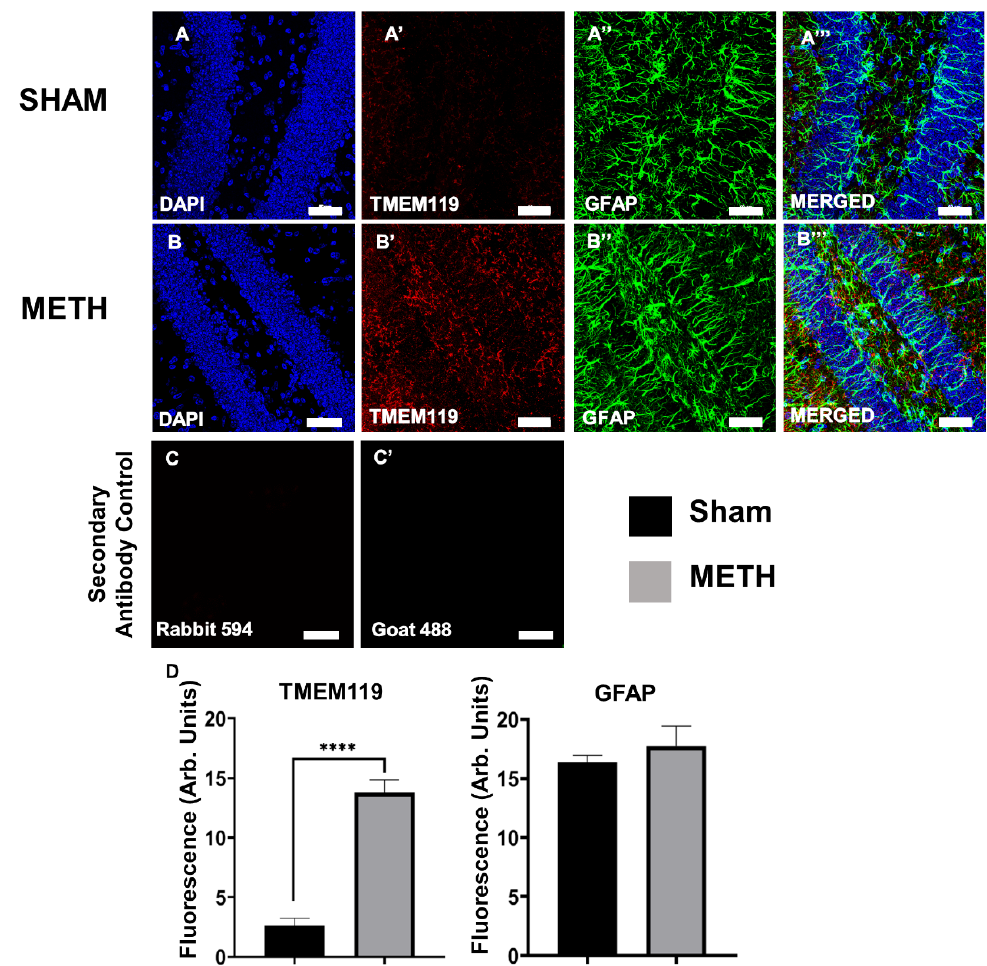
Figure 5. Acute METH exposure induces gliosis within the brain. Brain hippocampus cross-sections of sham-treated ( A , A’ , A’’ , A’’’ ) and METH-treated ( B , B’ , B’’ , B’’’ ) mice. ( A , B ) DAPI nuclei staining, ( A’ , B’ ) astrocytes labeled with anti-GFAP antibody, ( A’’ , B’’ ) microglial cells labeled with anti-TMEM119 antibody, and ( A’’’ , B’’’ ) merged images of DAPI, GFAP and TMEM119. Coronal sections; 20 μm; bregma −1.82 mm. Images captured at 40×, scale bar: 50 μm. ( C , C’ ) Secondary Antibody Control. ( D ) Statistical analysis of Fluorescence (Arb. Units). No significant differences were noted between the sham- and METH-treated mice in GFAP. Significant differences were shown between sham- and METH-treated mice in TMEM 119. Results are expressed as mean ± standard error of the mean (SEM), **** p <